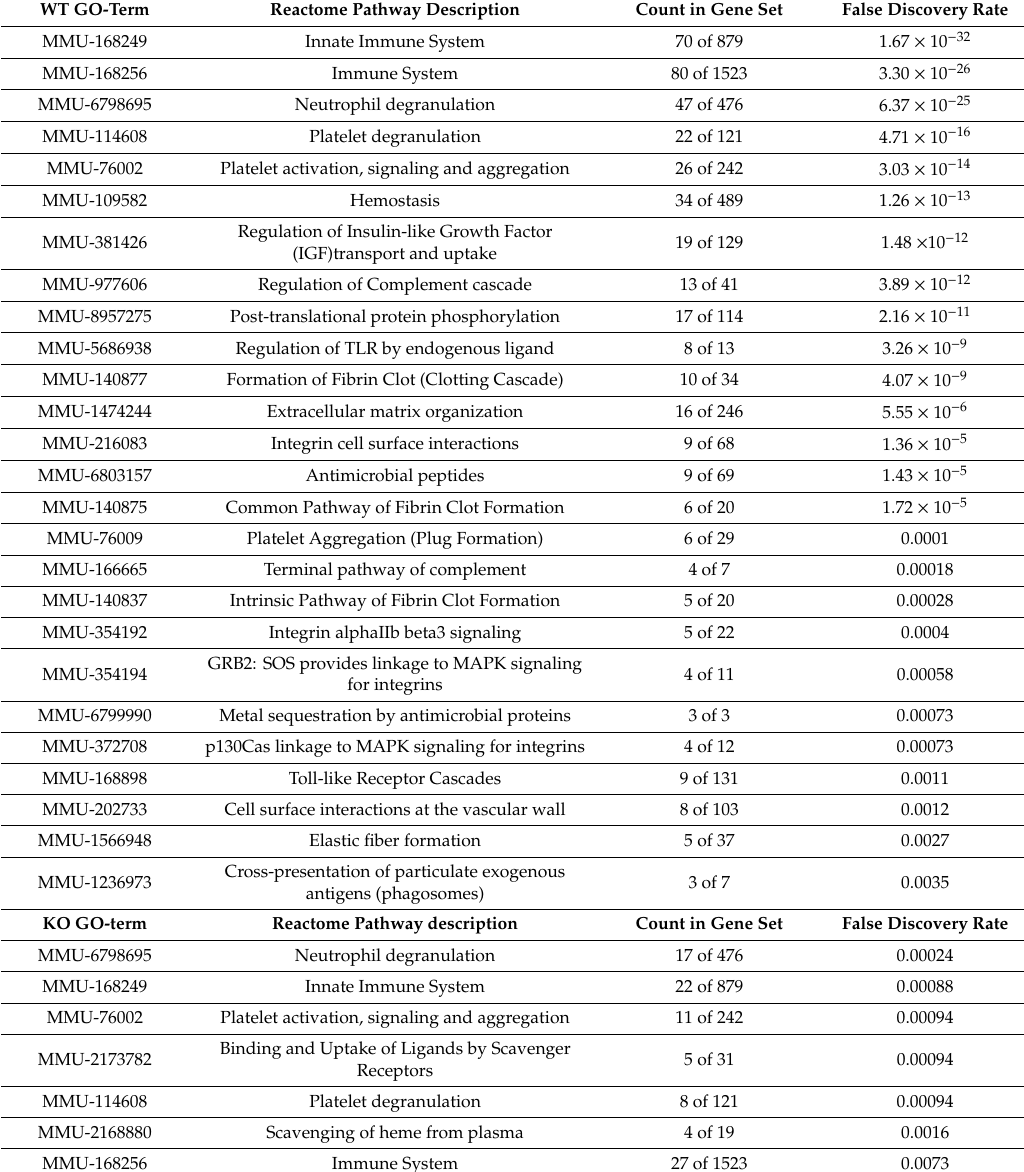
Table 3. Transcriptomics pathway analysis. Data showing reactome pathway description extracted from string database analysis (false discovery rate p <